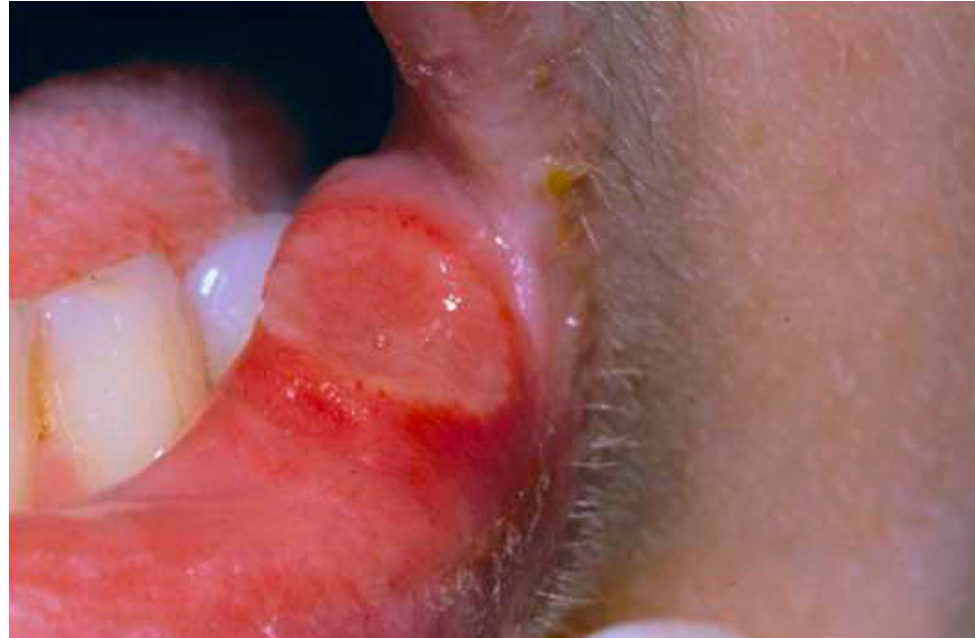
Figure 8. Clinical photograph of 28-year-old male patient with Behcet’s syndrome shows presence of punched out aphthous ulcerations on the lip mucosa. punched out aphthous ulcerations on the lip